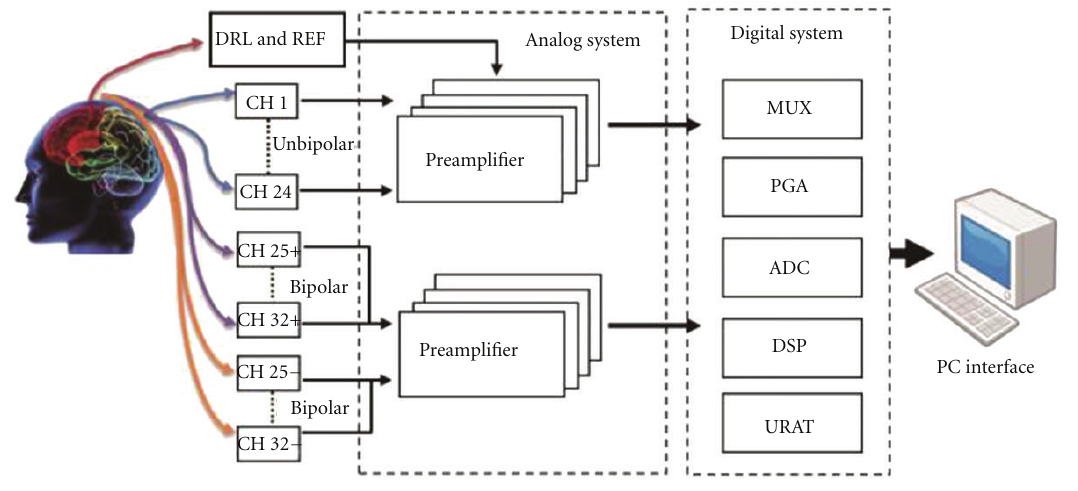
Figure 1: System